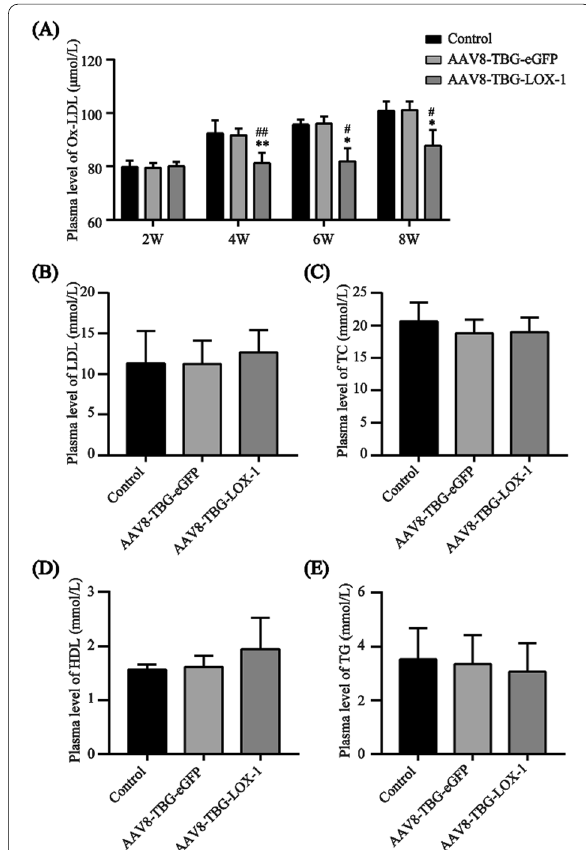
Fig. 3 Ox-LDL and lipid levels in plasma. A Detection of Ox-LDL in circulating plasma (ELISA, n 7). B Plasma LDL-C levels in mice = 8 weeks after virus transduction (n 7). C Plasma TC levels in mice = 8 weeks after virus transfection (n 7). D Plasma HDL-C levels in = mice 8 weeks after virus transfection (n 7). E Plasma TG levels in = mice 8 weeks after virus transfection (n 7). Values are expressed as = mean SD (n 7). *P < 0.05 and **P < 0.01 compared with the control ± = group. # P < 0.05 and ## P < 0.01 compared with the eGFP